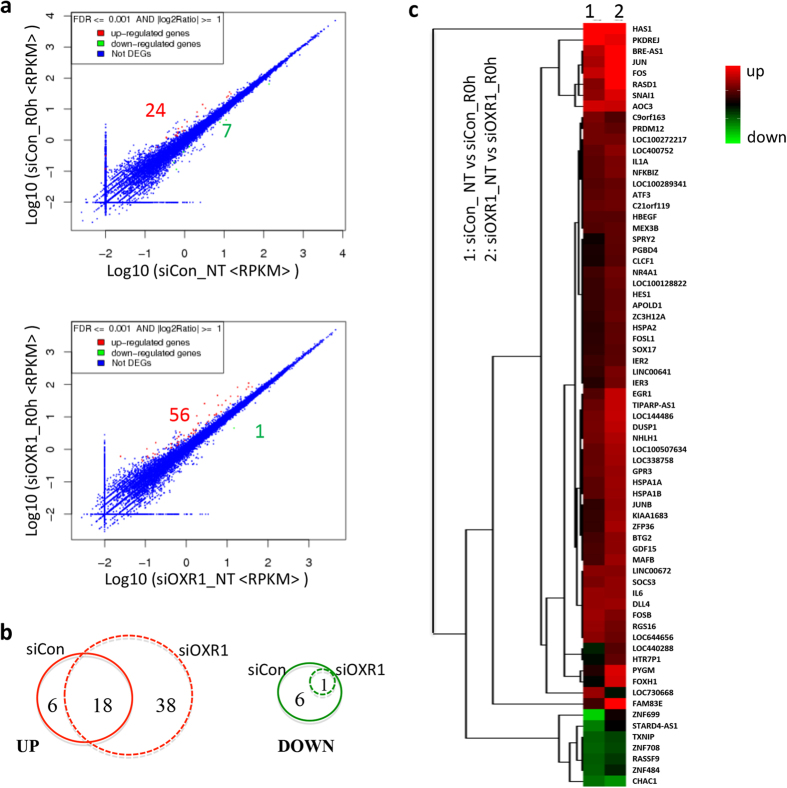
Identification of early oxidative stress response genes in control and hOXR1 depleted HeLa cells.(a) The differential expression profile induced by H2O2 in control siRNA (siCon_NT vs siCon_R0h) or hOXR1 siRNA transfected cells (siOXR1_NT vs siOXR1_R0h). The total numbers of up- or down-regulated genes are shown in red or green, respectively. (b) Venn analysis of commonly/uniquely up- or down-regulated genes in control siRNA and hOXR1 siRNA transfected cells. (c) Heatmap showing early oxidative stress response genes identified in control siRNA or hOXR1 siRNA transfected cells. Red: up-regulated genes; green: down-regulatied genes; black: no change; siCon: control siRNA; siOXR1: hOXR1 siRNA; NT: non-treatment; R0h: cells were treated with 0.5 mM H2O2 for1 h without recovery.